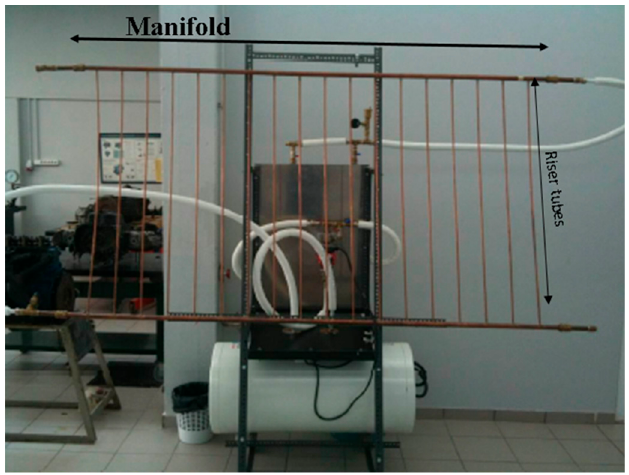
Figure 2. Experimental facility setup.